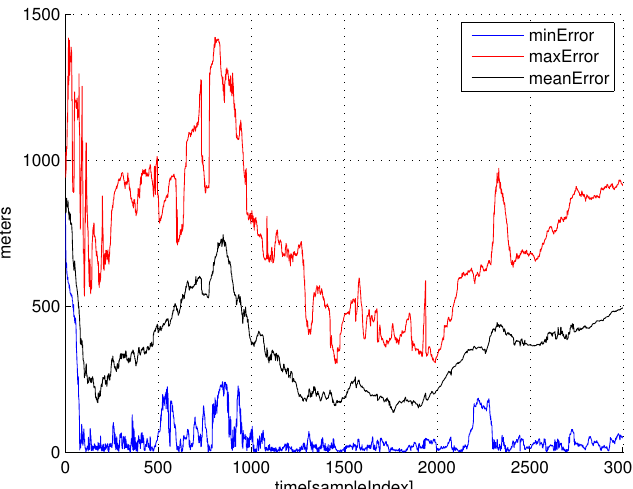
Figure 2. Consider the case where the proposed localization method is utilized. We plot meanE k , maxE k , and minE k with respect to sample-index k . The AUV maneuvers at 750 and 2250 s. At these moments, the estimation error decreases sharply. This is similar to the case where the maneuver of an observer makes the Bearing-Only Target Motion Analysis (BOTMA) system observable [36].